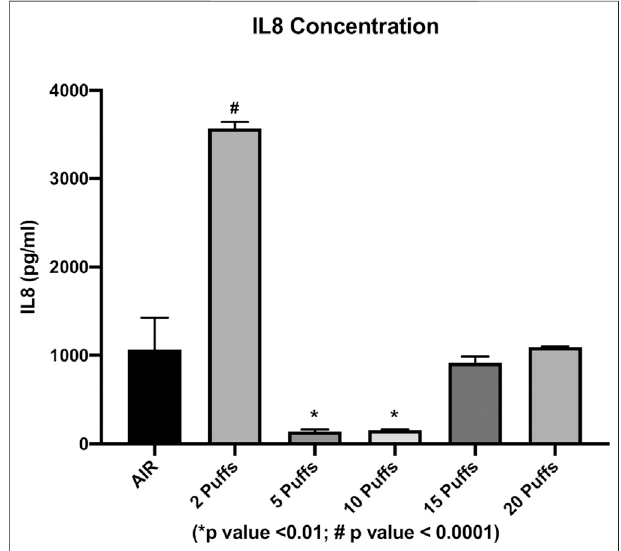
FIGURE 4 | IL8 concentration as a function of puff number of cigarettes 1R6F smoked under HCI (Health Canada Intense) regime. p values were calculated between each puff number vs. AIR